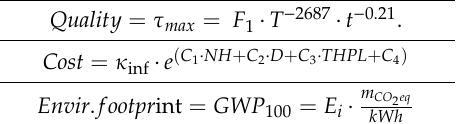
Table 1. Examples of objective functions of Quality, Cost and Environmental